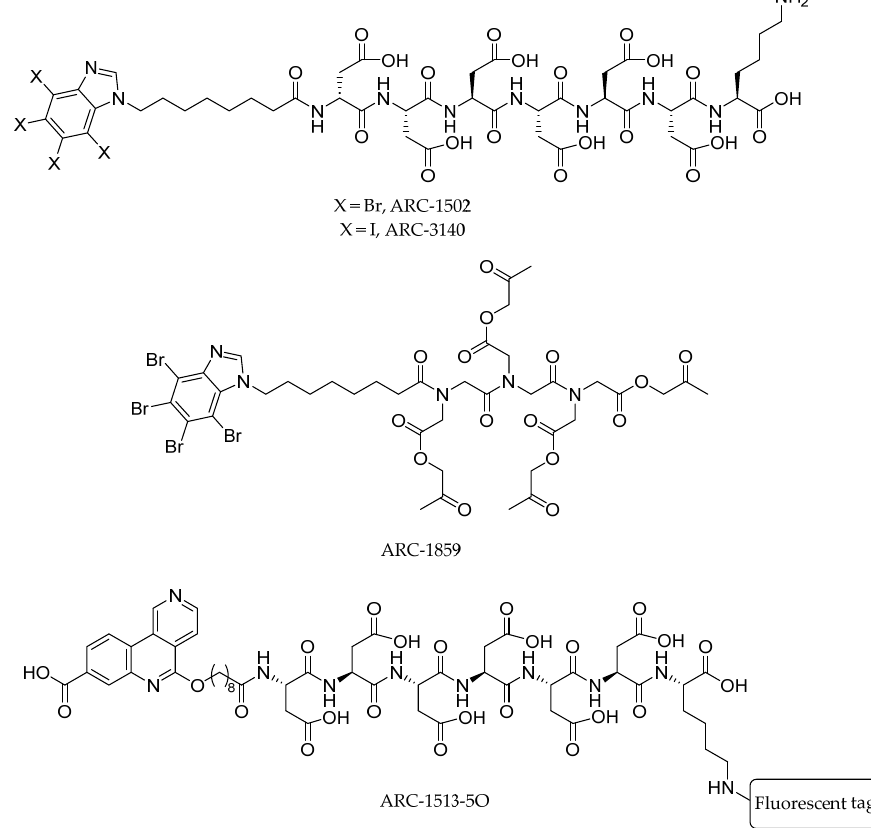
Figure 12. Structures of bi-substrate inhibitors of CK2: ARC-1502, ARC-1859, ARC-1513-5O and ARC-3140 [129–132].